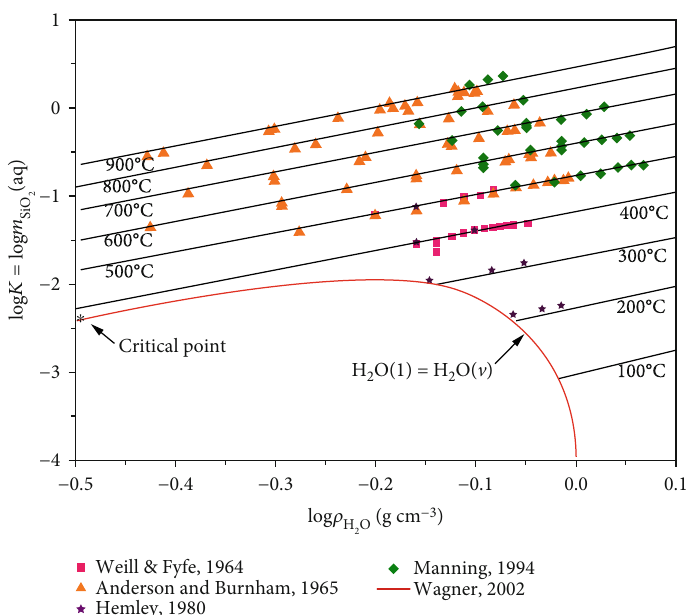
Figure 1: Log m versus log ρ for experimental studies and model predictions of quartz solubility at isothermal conditions in pure water. SiO 2 H 2 O Square, triangle, star, and diamond represent experimental data, and the asterisk is the critical point of H vapor pressure of H O, which is calculated from Wagner and Pruß [45], and the solid lines are log m 2